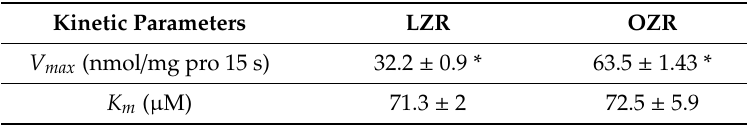
Table 1. Kinetic parameters of Na-taurocholate cotransport in the BBMV of villus cells from OZR and LZR. The maximal rate of uptake was found to be significantly increased in the villus brush border membrane vesicles from OZR compared to that from LZR ( n = 4; * p < 0.05). However, the a ffi nity for bile acid uptake remained unchanged between the two experimental conditions.